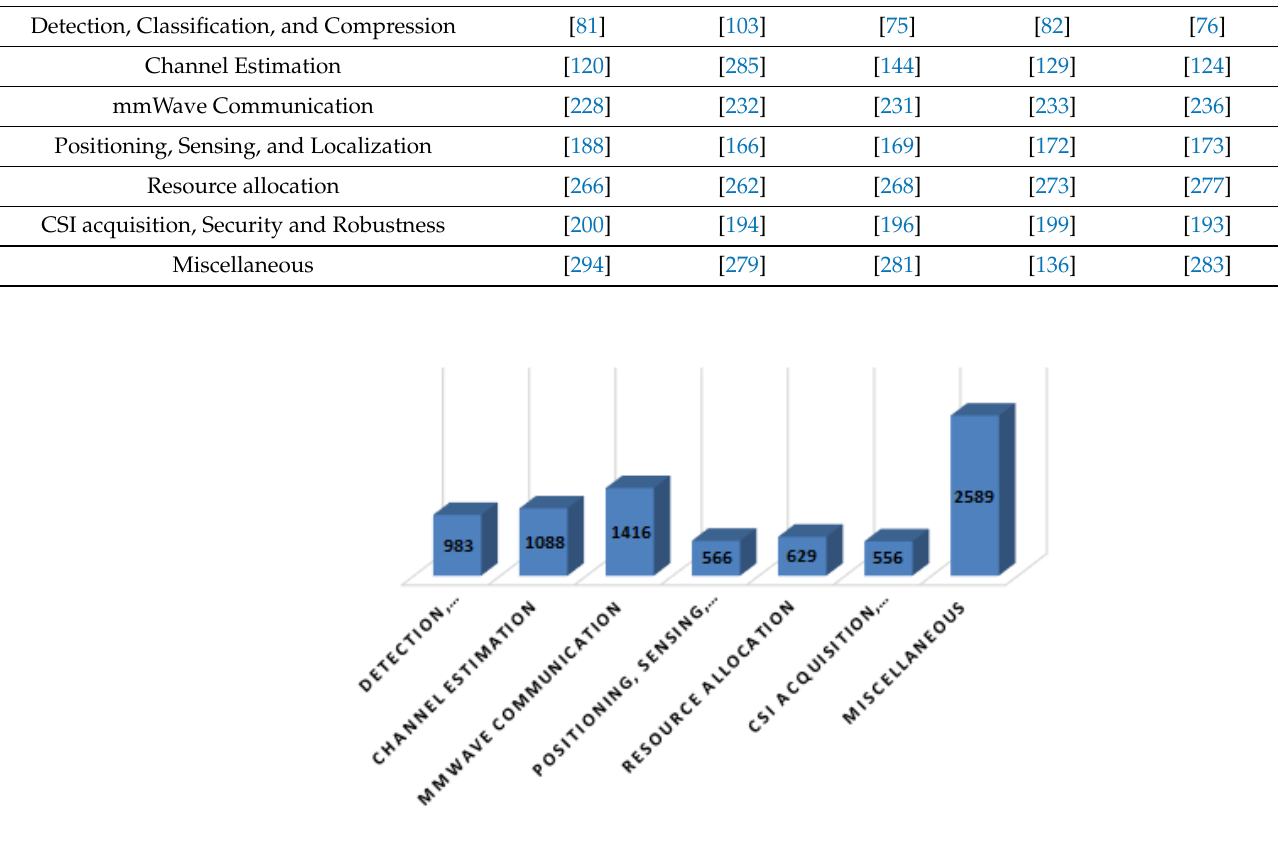
Figure 8. Number of citations by